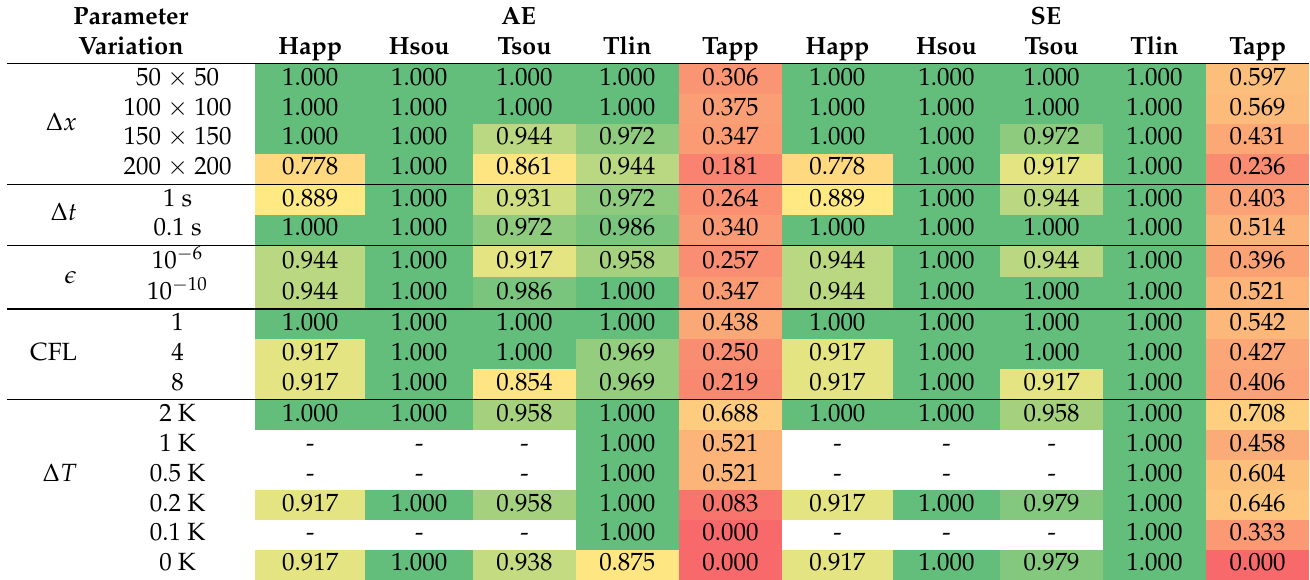
Table 3. Ratio of simulations with a final liquid fraction from 60% to